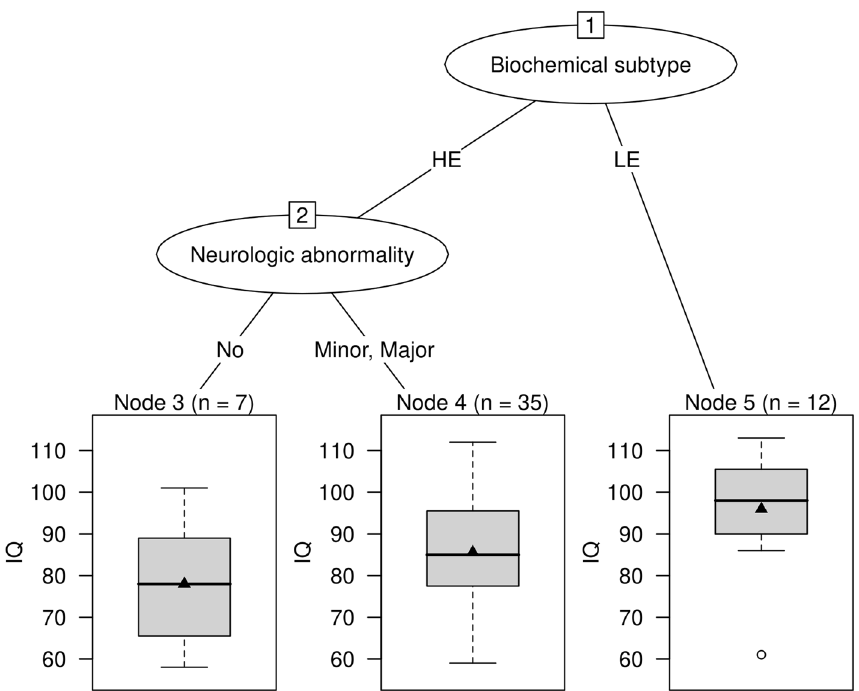
Figure 3. Biochemical subtype, neurologic abnormalities and full scale IQ. While biochemical subtype had a strong impact on full scale IQ, neurologic abnormalities did not. Patients with HE phenotype and minor neurologic abnormalities (median IQ [horizontal line in box] 78; IQR 66–89) had lower results than LE patients (median [IQR] IQ 98 [92–105]; p = 0.0278). Results of HE patients did not differ depending on neurologic abnormalities (p = 0.4045). Black triangles indicate mean IQ. HE high excreter, LE low excreter.